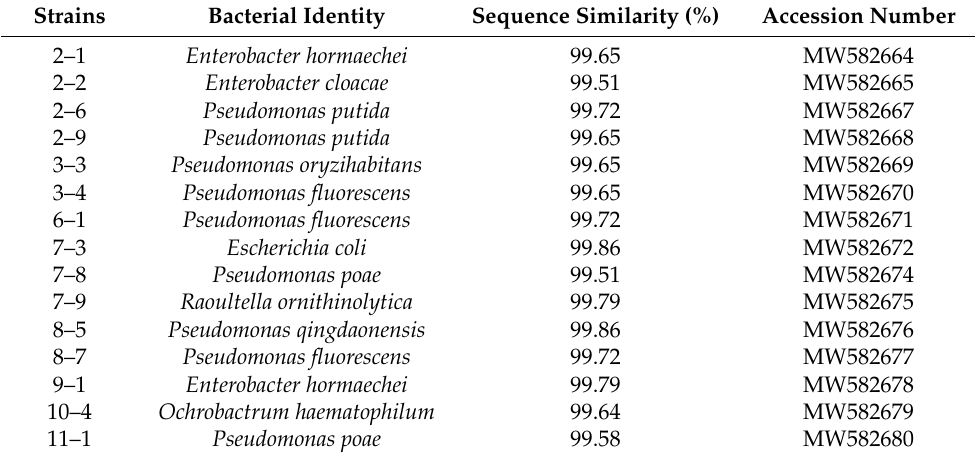
Table 8. Identification of representative isolates of P-solubilizing and N-fixation bacteria based on analysis of 16S rDNA